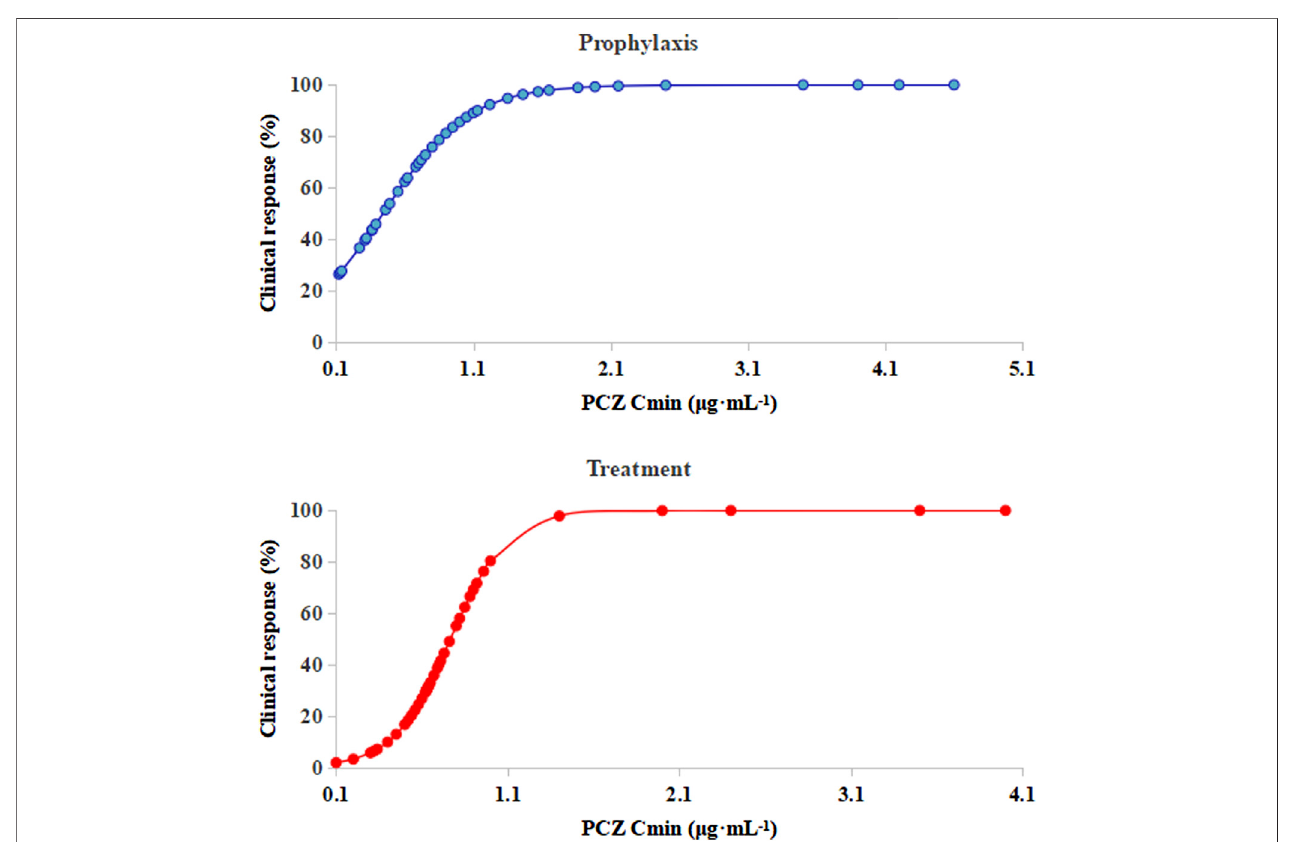
FIGURE 5 | Logistic regression model showing PCZ C min predicting the probability of successful clinical response of prophylaxis and treatment. The solid lines represent the regression fi t; C min , posaconazole average steady-state plasma concentrations.